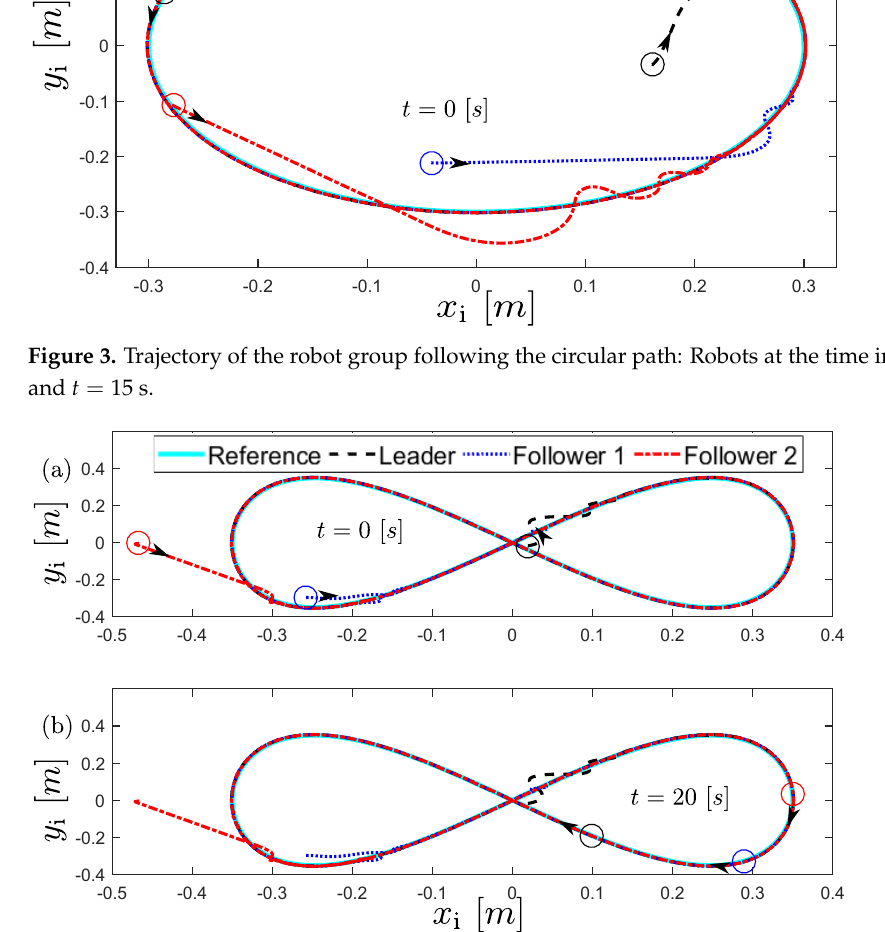
Figure 4. Trajectory of the robot group following the lemniscate curve: ( a ) Robots at t = 0 s, and ( b ) Robots at t = 30